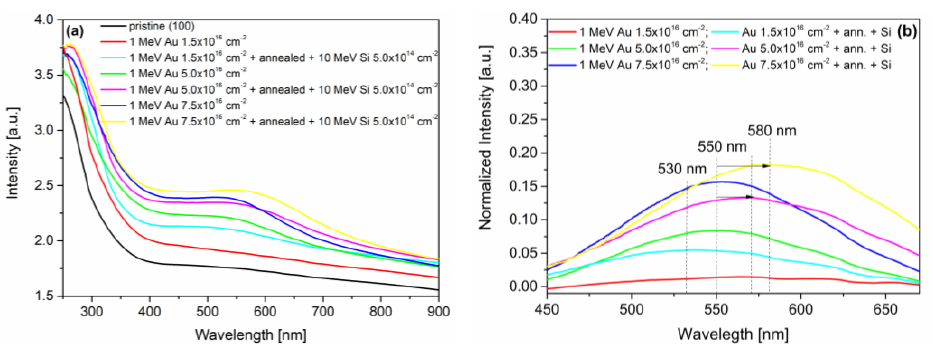
Fig. 2. Optical absorption spectra of the Au-implanted (100)-oriented YSZ (Au: YSZ) and Au: YSZ, annealed and Si-irradiated in the wavelength range from 250 to 900 nm and the zoom of the region of interest in 450-680 nm wavelengths is presented